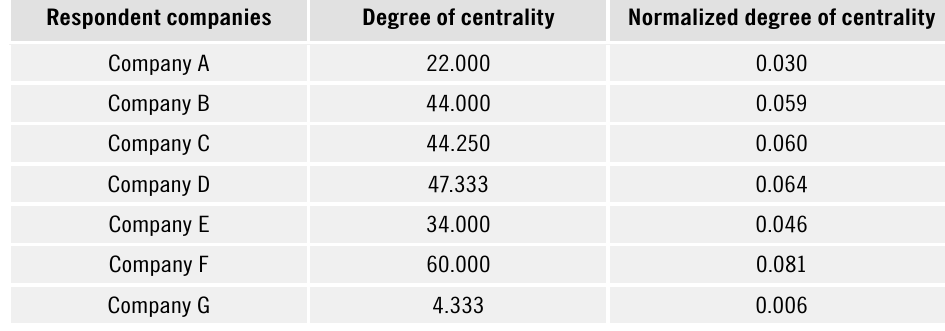
Table 11. Degree of centrality parameters of the respondent